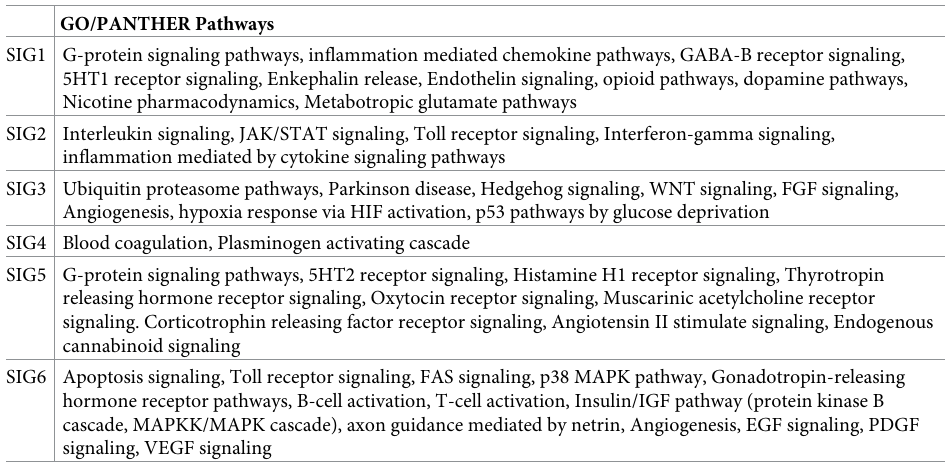
Table 3. The functional annotations of the six genes sets